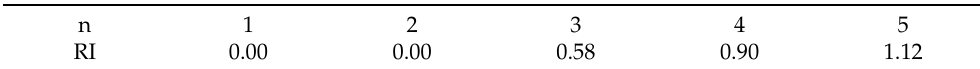
Table 3. Random index (RI)